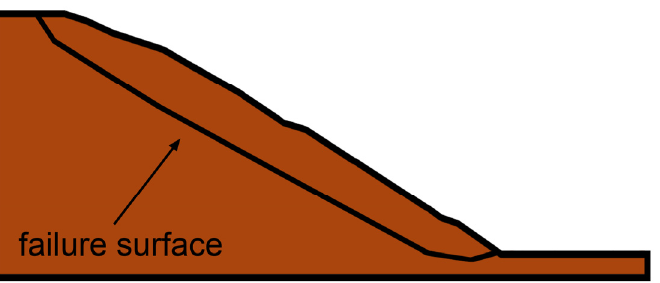
Figure 20. Schematic section of the embankment affected by failure (modified from [55]).